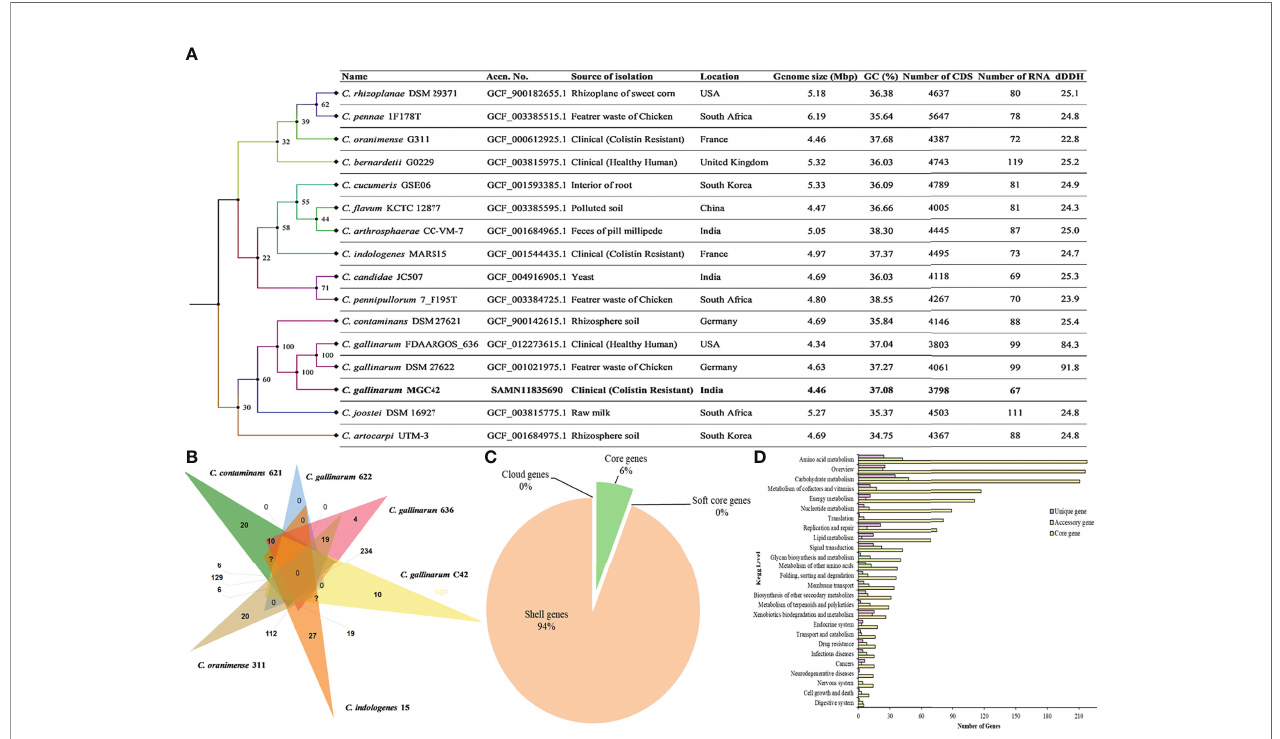
FIGURE 1 | (A) Whole-genome – based phylogenetic tree between C. gallinarum MGC42 and other Chryseobacterium strain. Sequence highlighted the position of C. gallinarum MGC42 with their metadata. Phylogenetic inferences were obtained through TYGS tools. The branch color represents the bootstrap value. The branches of the tree are indicated by the genus and species name with type strains followed by other metadata of the respective species. (B) Venn diagrams generated by OrthoVenn show the distribution of shared and unique genes among six different sets of Chryseobacterium spp. (C) Core and accessory genes of C. gallinarum strains. (D) The numbers of core, cloud, soft, and shell genes were calculated by Roary. The core genes are shared by all the included organisms in the pangenome